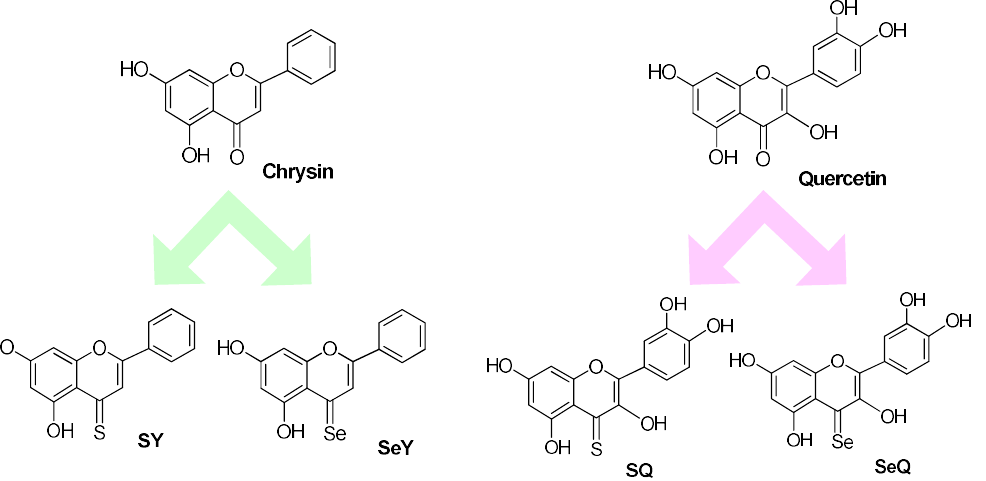
Figure 3. Chemical structures of natural flavonoid (e.g., chrysin and quercetin) and their sulphur and selenium derivatives. selenium